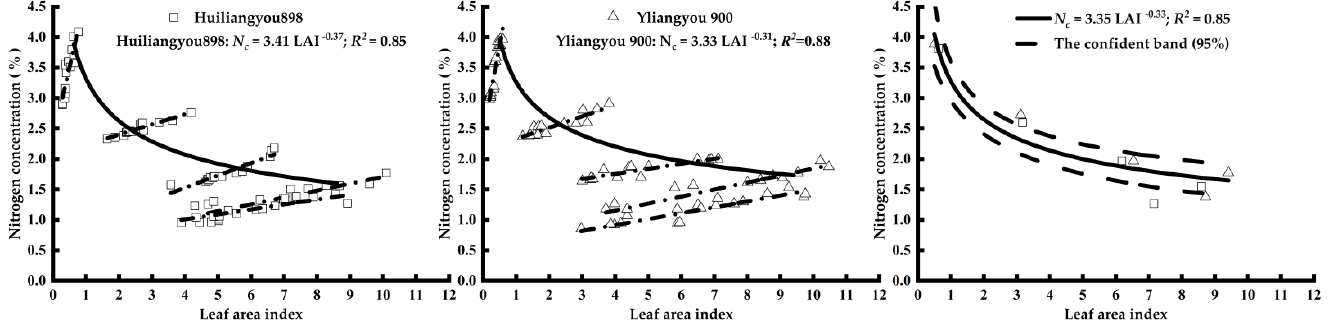
Figure 5. Relationship between the LAI and N c of indica hybrid rice grown from machine-transplanted bowl seedlings.